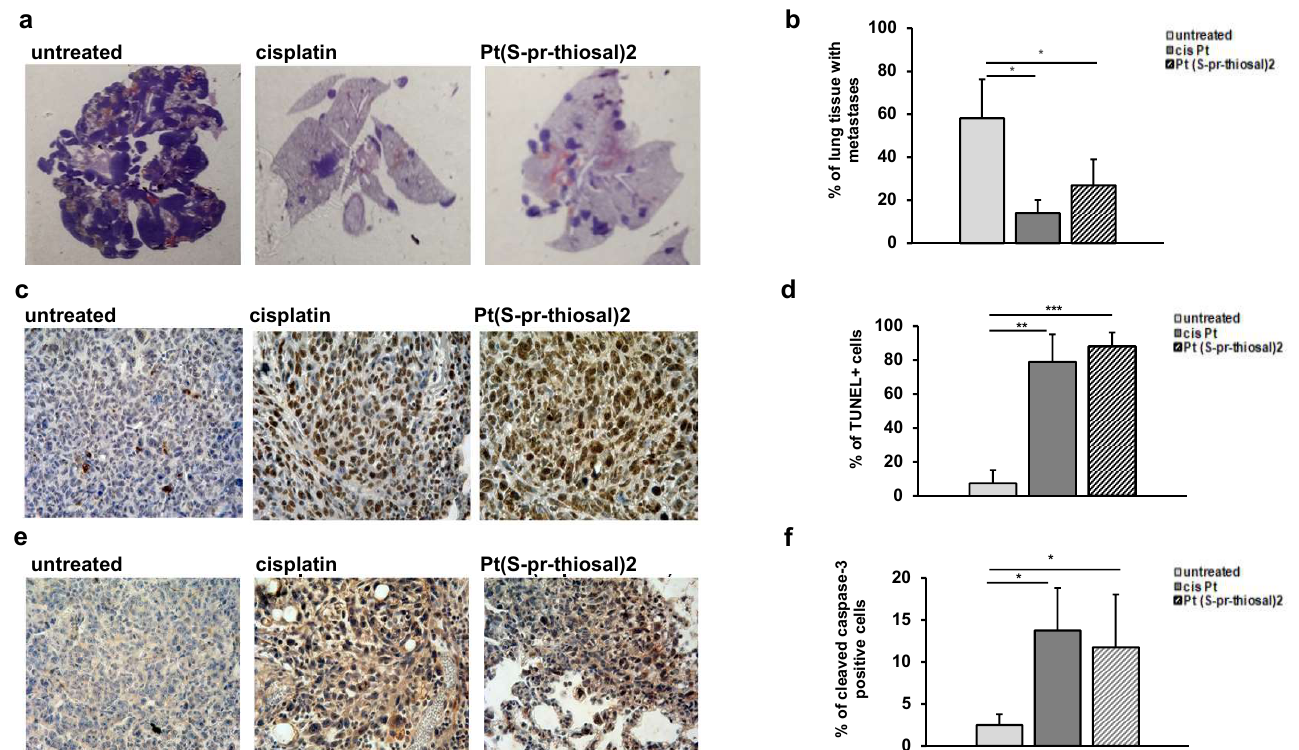
(Figure 3f). There was no difference in the percentage of caspase-3 positive cells between the cisplatin-treated groups of mice and the Pt( S -pr-thiosal)2 complex